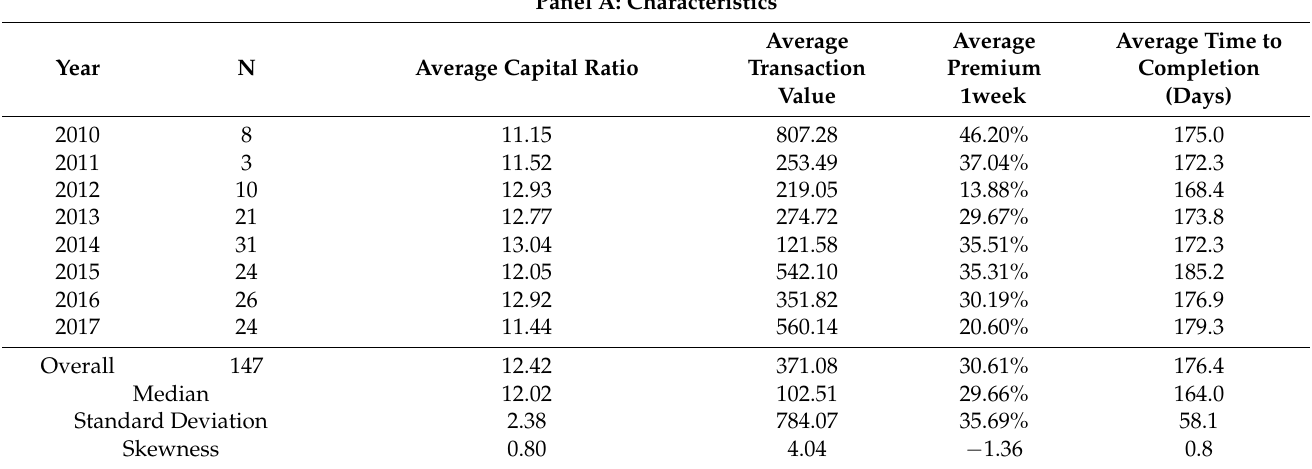
Table 1. Banks: Characteristics, Returns, and Performance. The three panels of this table show the time series (year by year) of transaction and acquirer characteristics as at the time of M&A announcements, announcement period abnormal returns, and post issue abnormal returns and post issue performance, for banks. Other summary statistics include median, standard deviation, and skewness; and, they are reported for the overall sample immediately below the year-by-year averages. Panel A: Characteristics